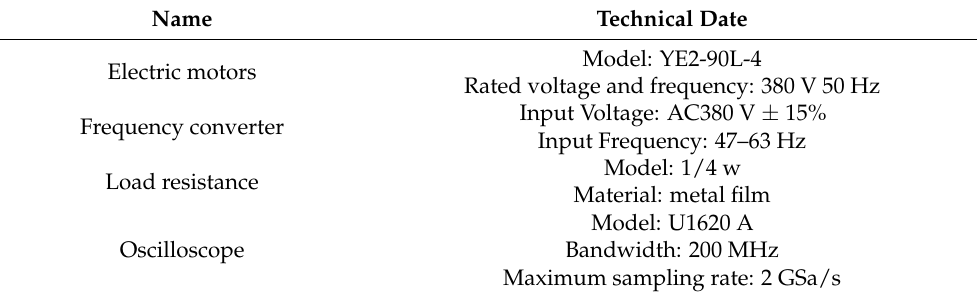
Table 3. The characteristics of the